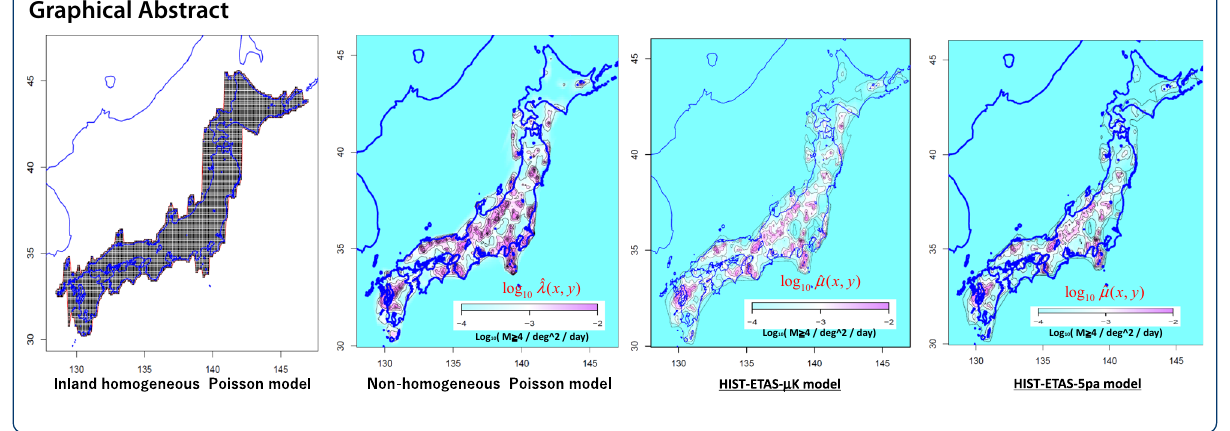
(cid:31) (cid:30) log Posterior (θ | w ) d θ w �